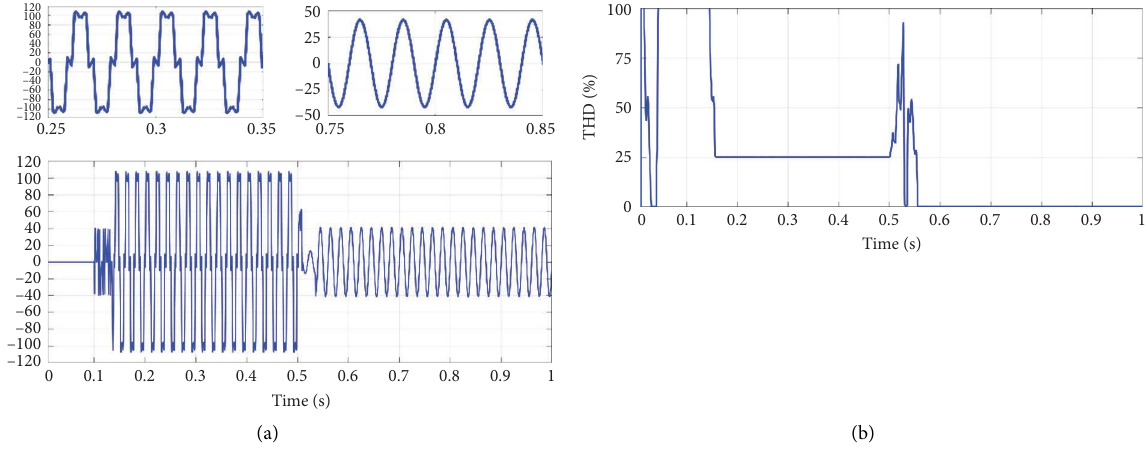
Figure 16: Filter current injected by PV system (a) and its THD (b).